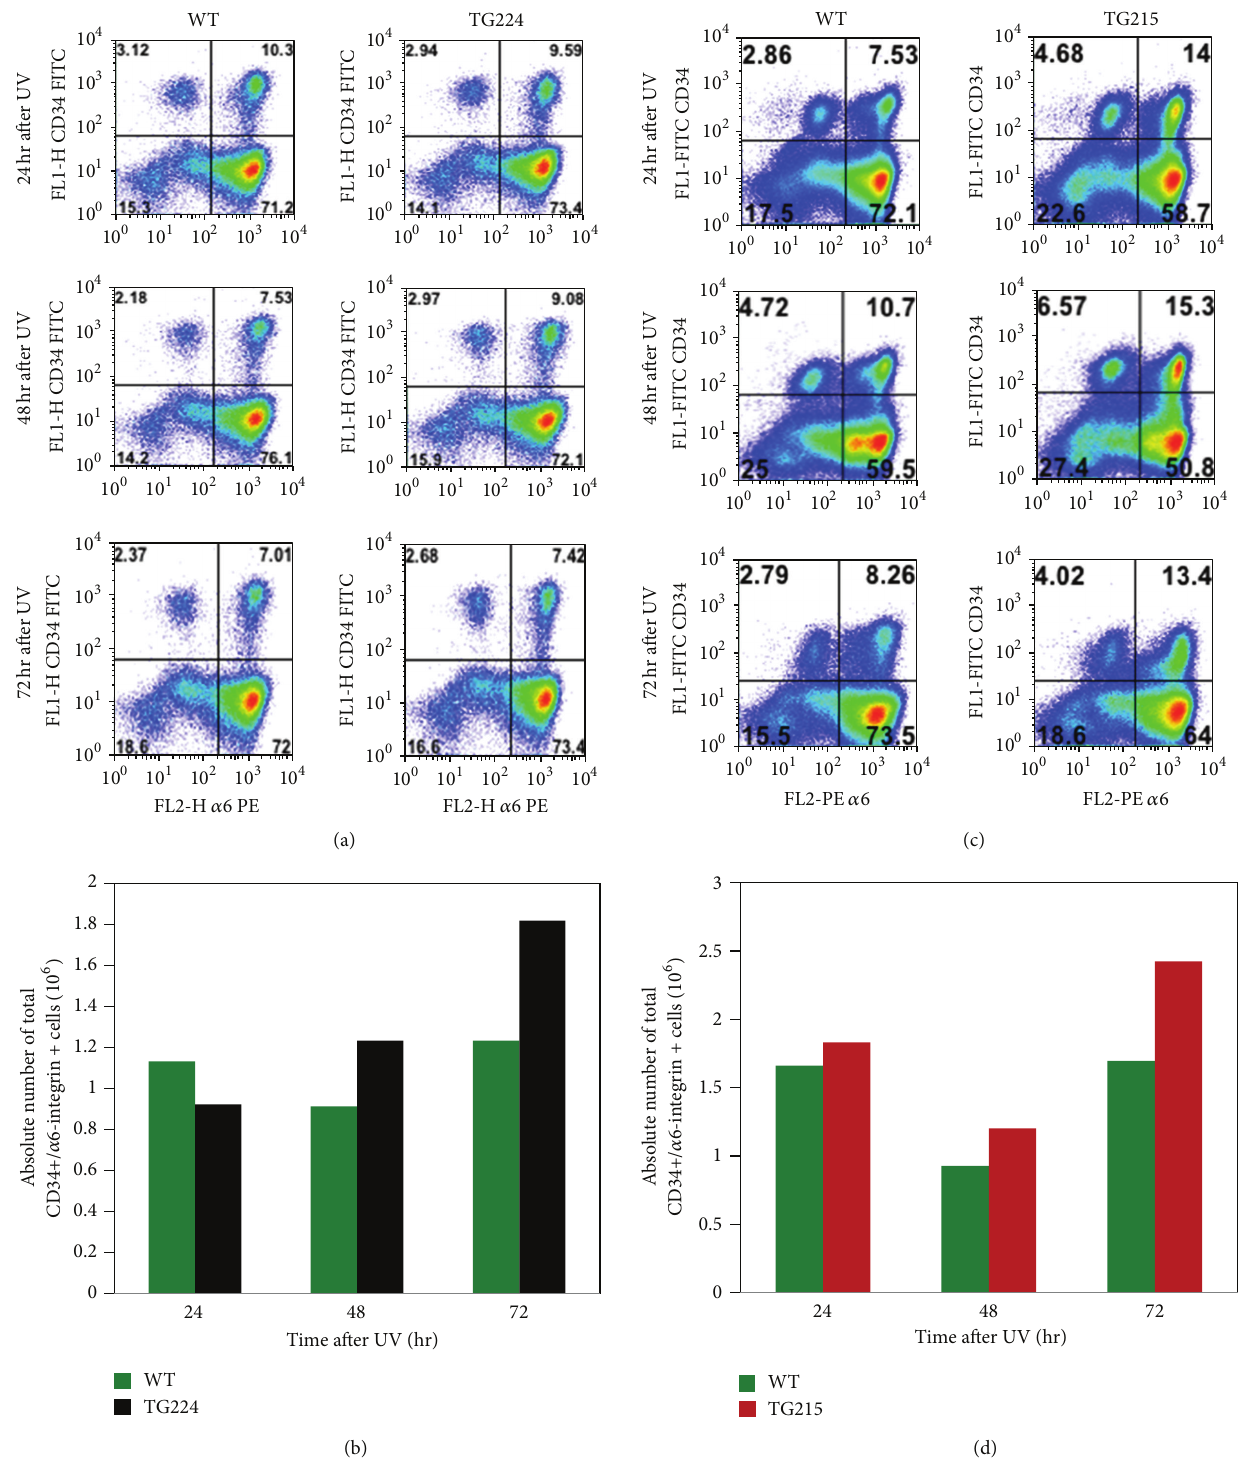
Figure 2: Effects of single UV exposure on live epidermal stem cell population determined by flow cytometric analysis. PKC 𝜀 overexpressing TG and their WT littermates were exposed once to UV (1.8kJ/m 2 ). At the indicated times after UV, mice were sacrificed and the dorsal skin removed for keratinocyte isolation as previously described [21]. (a) and (c) Percent distribution of FACS-sorted keratinocytes following UV exposure of the indicated mice at the indicated times after UV exposure. (b) and (d) Frequency of total double positive HSCs (CD34+/ 𝛼 6- integrin+) in TG224, TG215, and their WT littermates at the indicated times after single UV